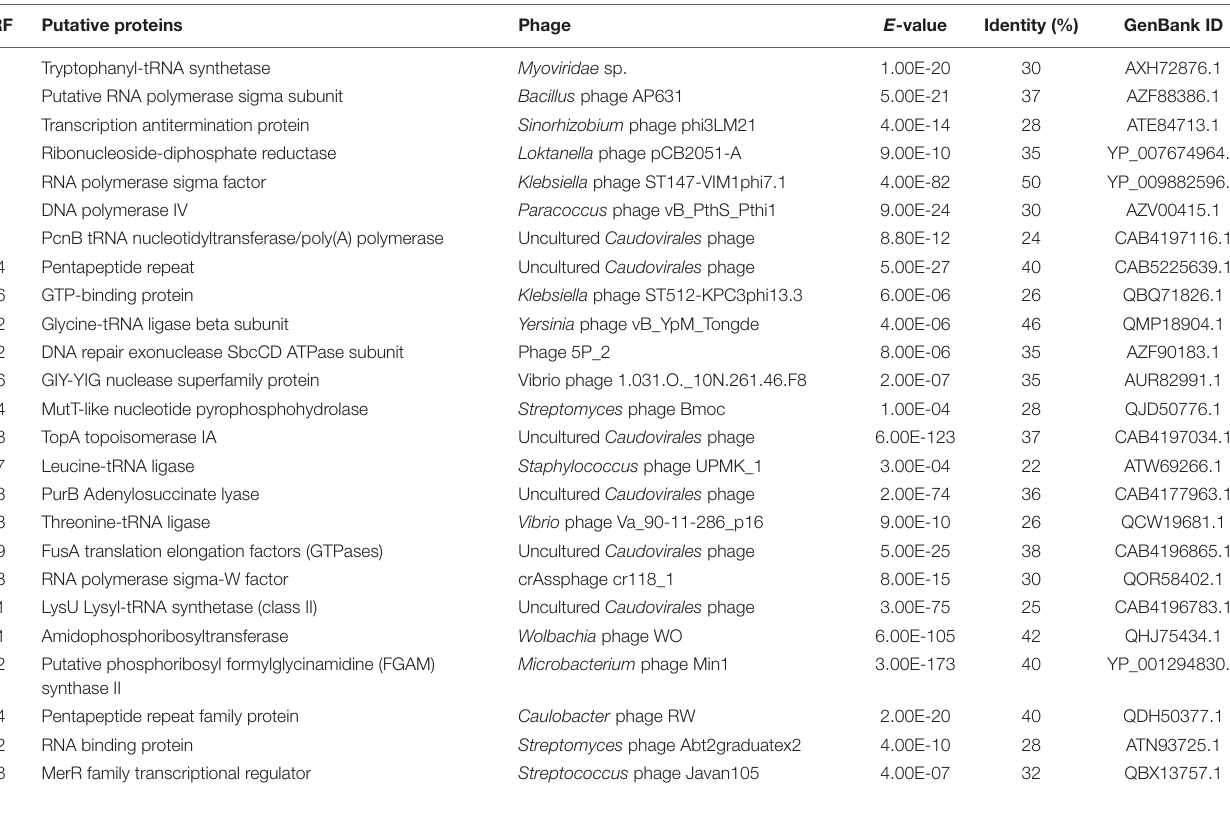
TABLE 1 | Predicted ORFs of cyanophage PhiMa05 with similarity to genes of know function.